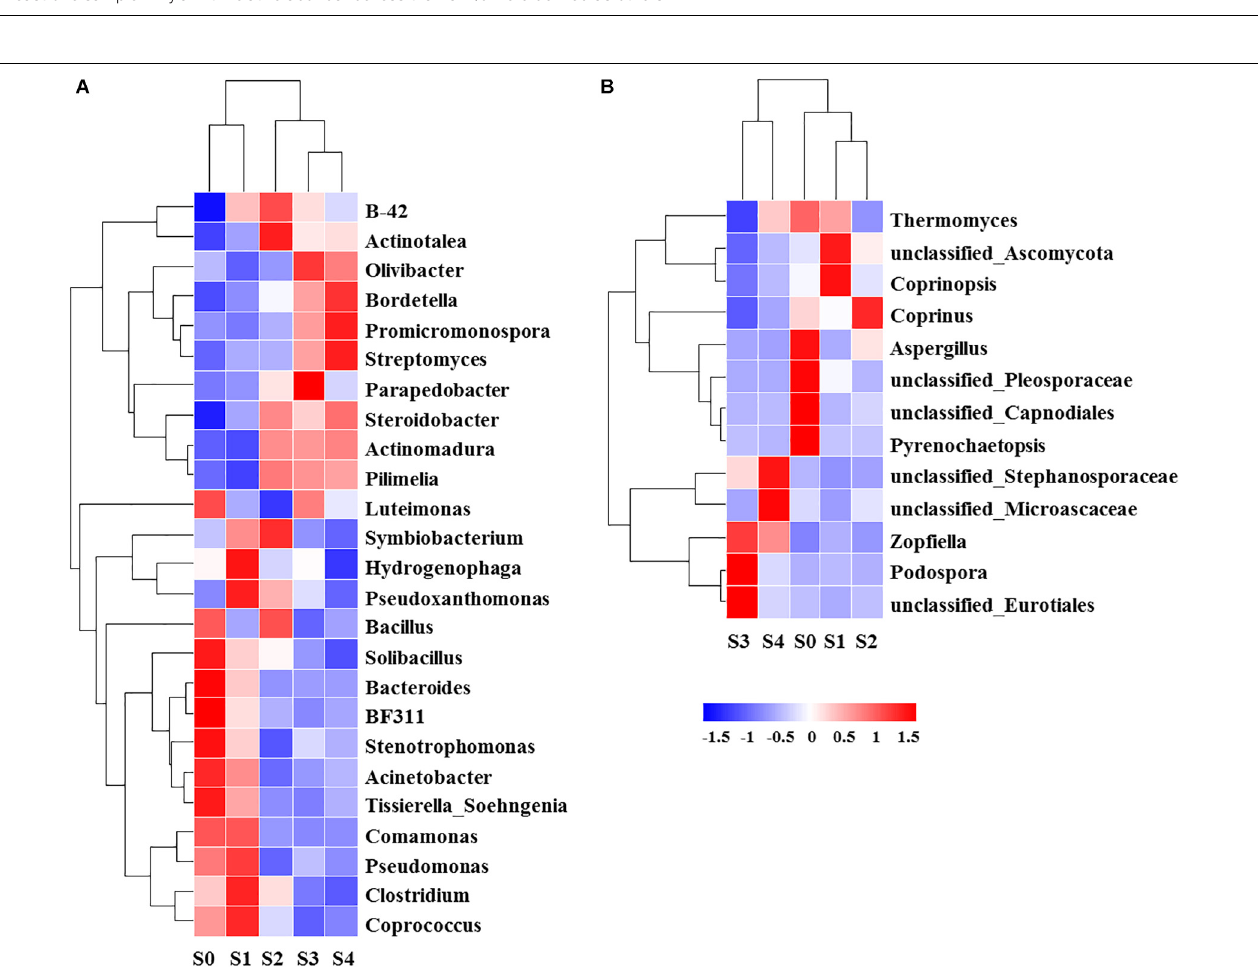
FIGURE 4 | Relative abundance [log 2 (x+1)] of top genera (relative abundance percentage > 1%) of bacterial (A) and fungal (B) at different composting stages.